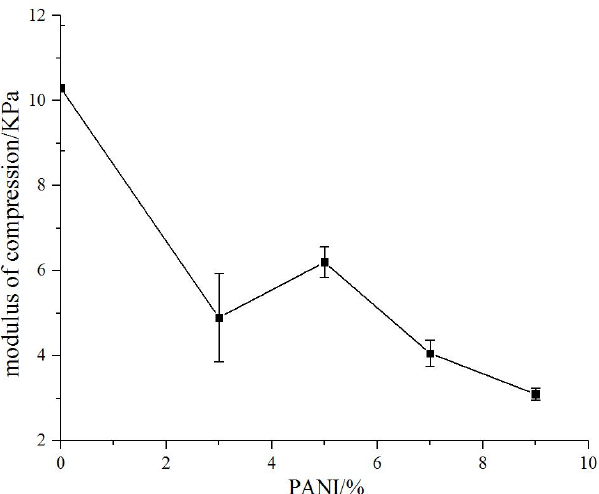
Figure 4. Compression modulus curve of the bio conductive materials with different polyaniline concentrations.